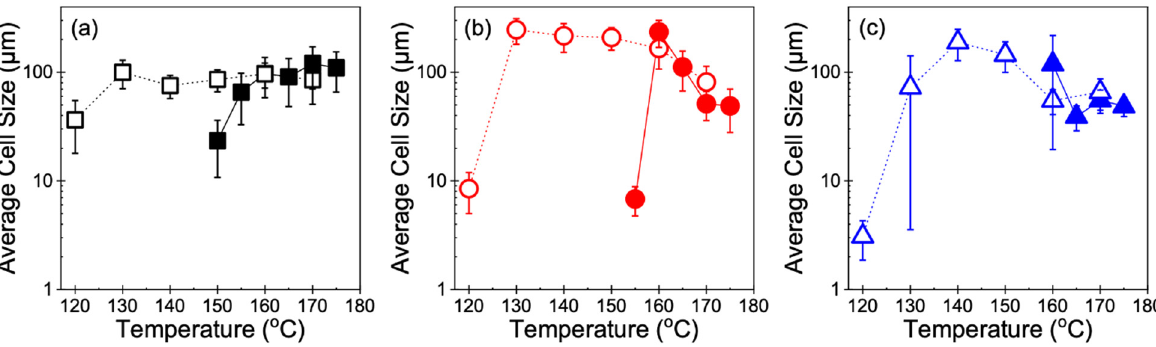
Figure 10. Average cell sizes of ( a ) Resin A, ( b ) Resin B, and ( c ) Resin C foams. Closed and open symbols (with lines as a guide to the eye) correspond to Method 1 and Method 2, respectively.